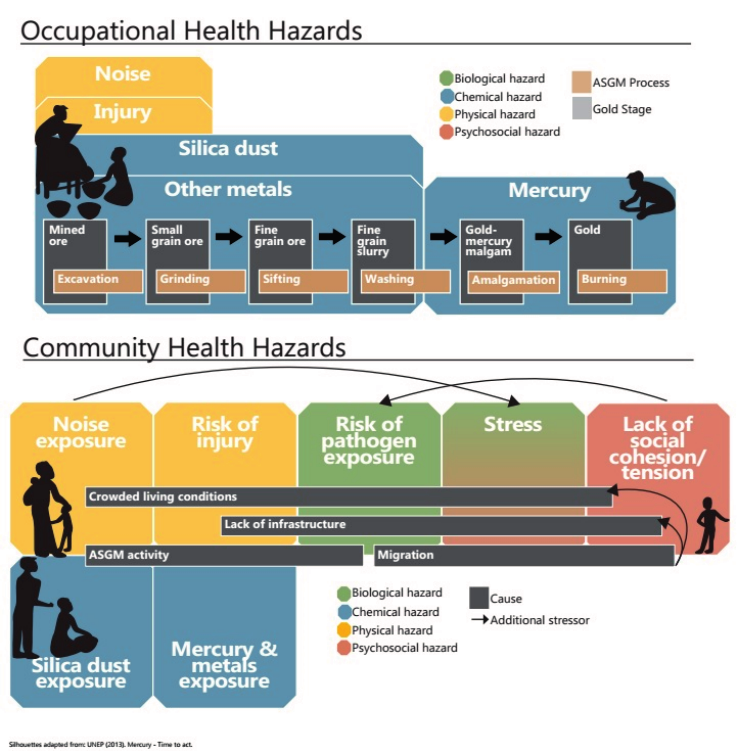
Figure 2. Key occupational (top panel) and community (bottom panel) human health hazards in the Ghanaian artisanal and small-scale gold mining (ASGM) sector. Silhouettes adapted from UNEP Mercury: Time to Act (2013)